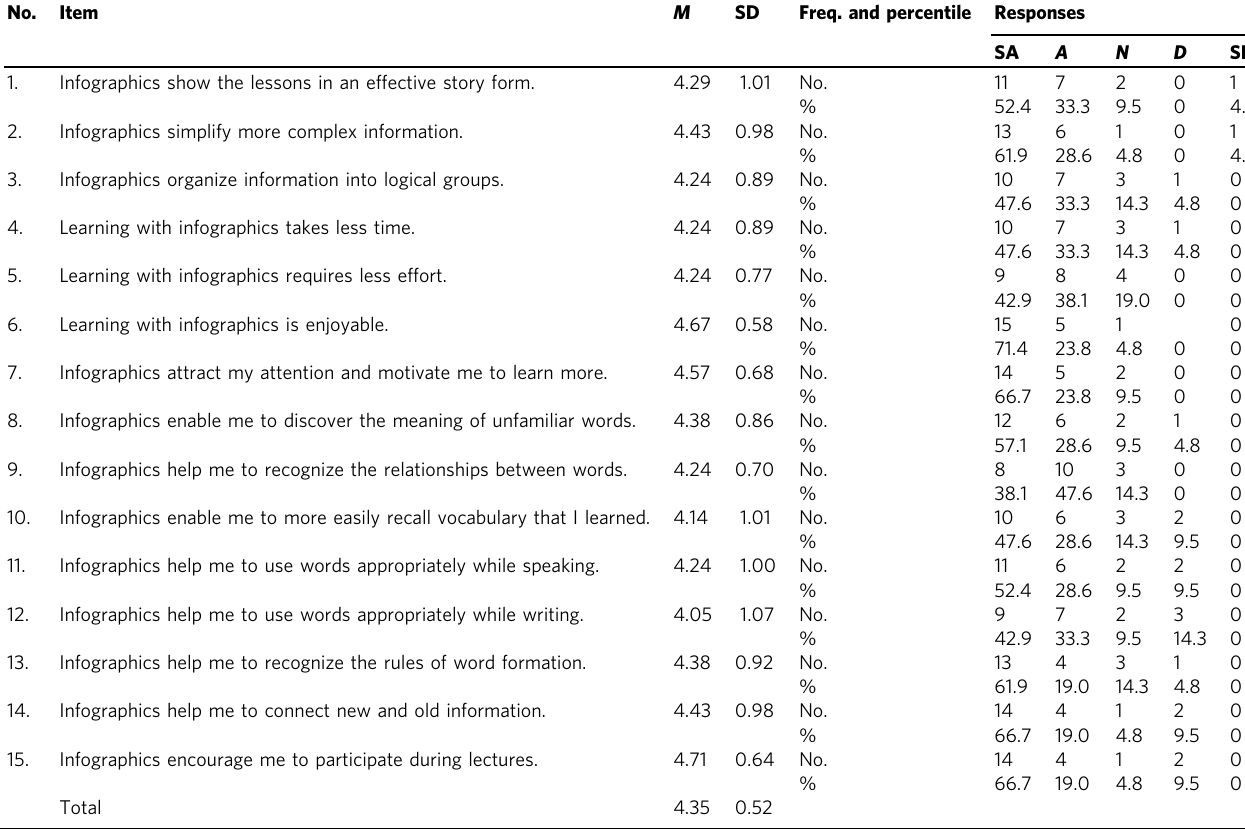
Table 3 Descriptive statistics of the students ’ perceptions toward learning English vocabulary via infographics. No.